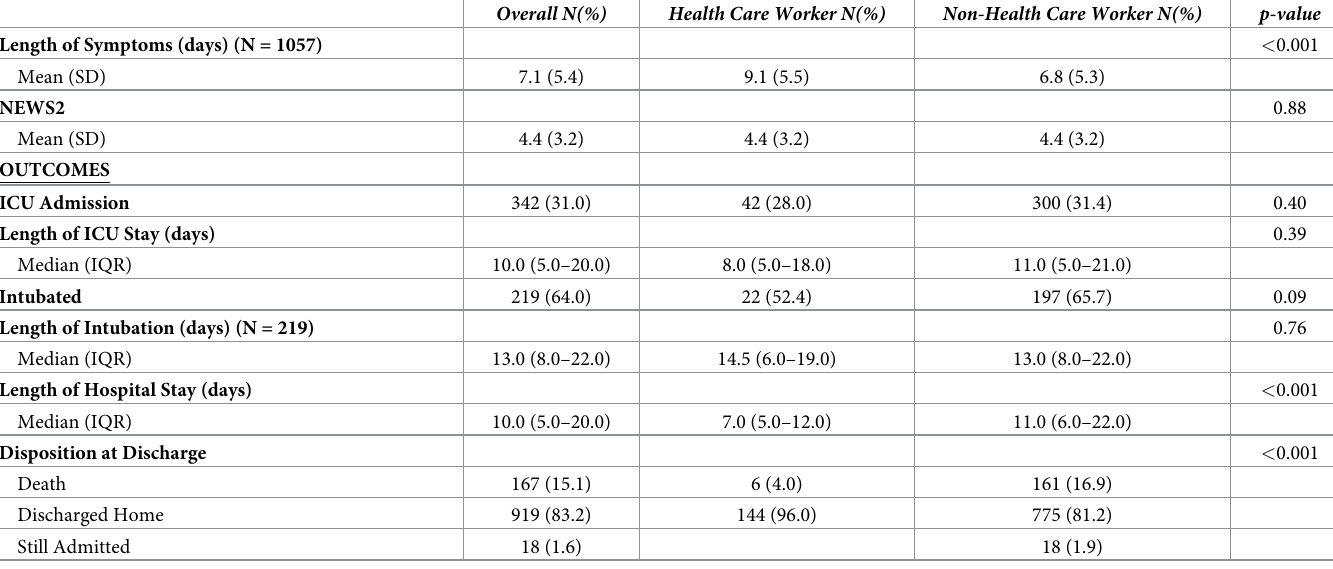
HCW were primarily PSW (47.6%) and nurses (15.9%). Health care workers by immigration status and ethnicity A total of 68.0% (102/150) of all HCW were immigrants. Immigrant and non-immigrant HCW had a similar age (mean, 50.2 vs 48.5; p = 0.41), sex (64.7% vs 50.0% females; p = 0.09),